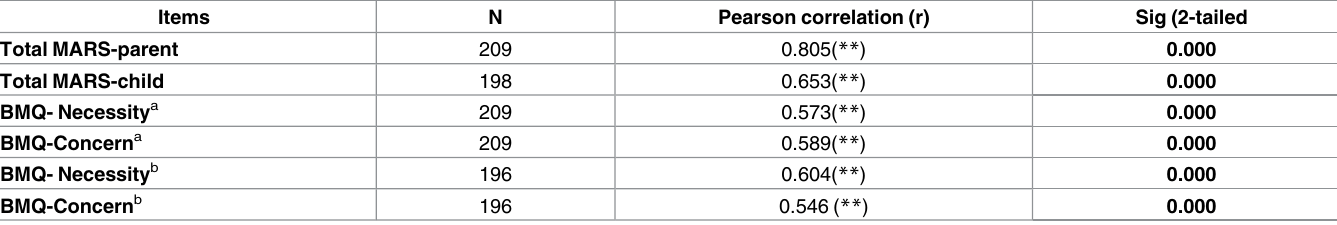
construct validity as principal component analysis revealed that they clearly measured one con- struct i.e. non-adherence. This was illustrated by the distinctive scree plot and only having one component with an Eigenvalue over 1 and the fact that this component accounted for 40.5% and 51.9% of the variance in MARS-parent and MARS-child questionnaires respectively. The validity results for the BMQ-concerns and necessity scales for parents and children were also good. All questionnaires established sampling adequacy, with all KMO values being (cid:21) 0.68. The scree plots clearly showed that one key component was measured.